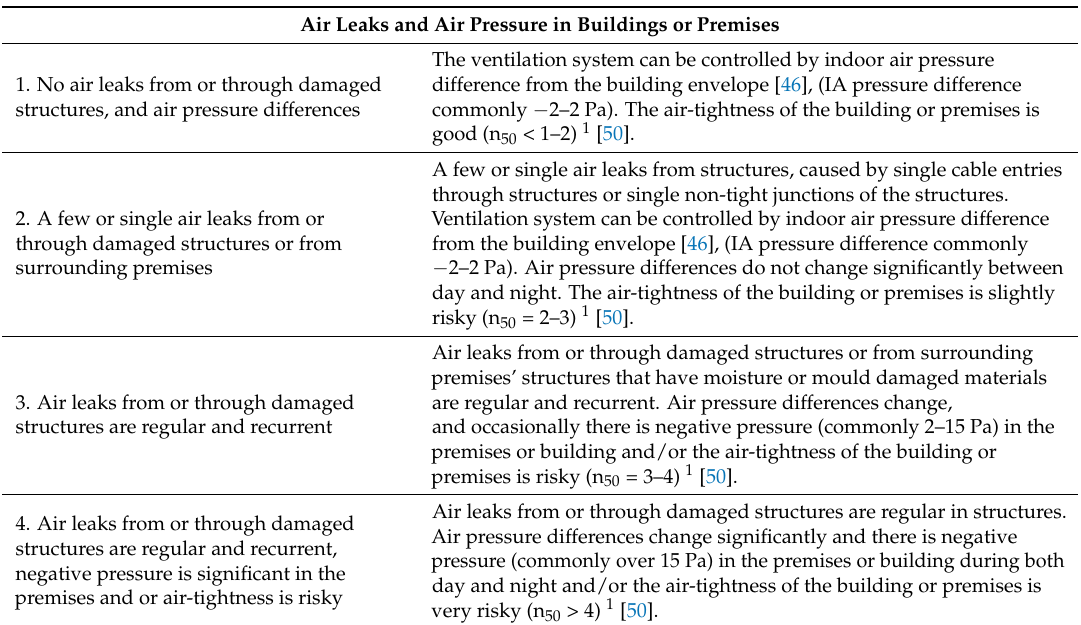
Table 2. Main criteria for assessing air leaks and air pressure in buildings or